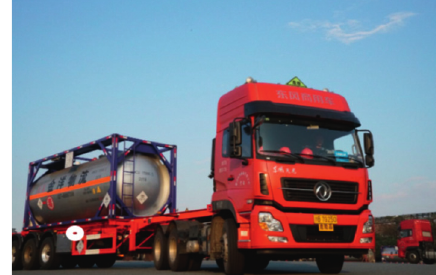
Figure 4: Nine-axis gyroscope installation